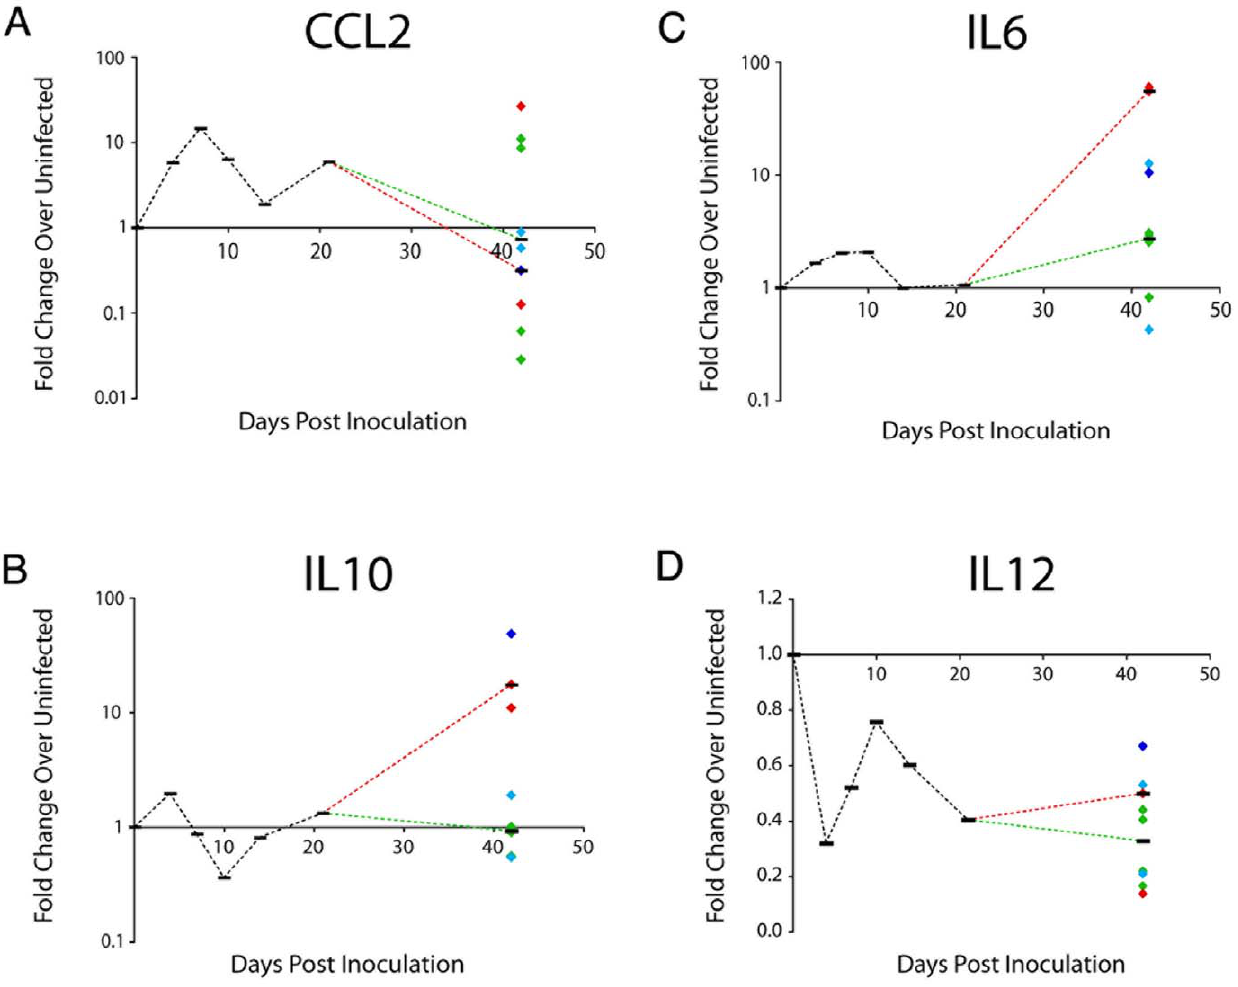
Figure 5. CCL2, IL6, IL10, and IL12 mRNA in brain of SIV-infected macaques. mRNA was isolated form brain of uninfected and SIV-infected macaques at terminal time points (4, 7, 10, 14, 21, or 42 days after inoculation). mRNA levels for A) CCL2; B) IL6; C) IL10; and D) IL12 was measured by quantitative RT-PCR and mRNA levels in the SIV-infected are represented as fold change over the average of the uninfected values, calculated by DD Ct. Medians (black bars) for each experimental group are indicated. For the 42-day group, each diamond represents one animal, color-coded according to CNS disease severity (red-severe; blue-moderate; turquoise-mild; green-none). The black bars represent the medians for severe/ moderate (red dotted line), and mild/none animals (green dotted